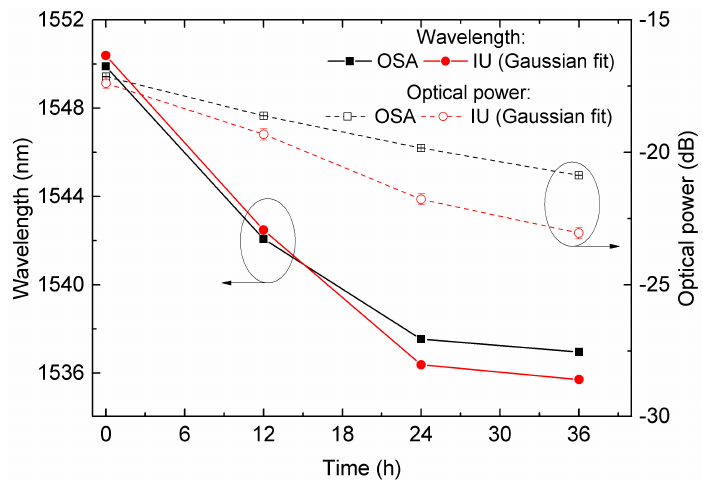
Figure 14. IU measurements for corrosion in salt water of a 20 nm thick Fe-coated LPFG in terms of the peak wavelength and optical power. The measurements obtained by the BBLS/OSA scheme are presented for comparison.